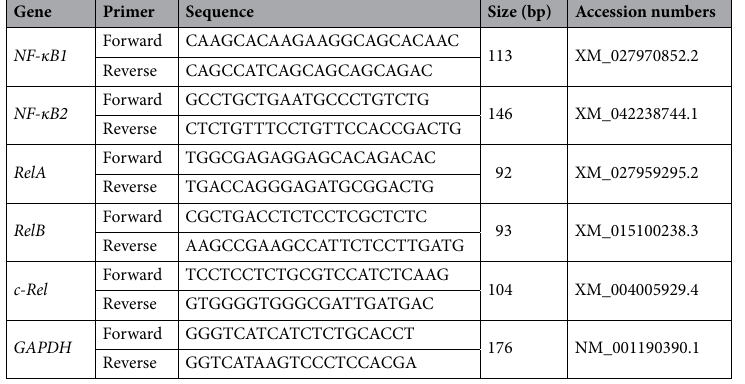
Table 1. Primers used for